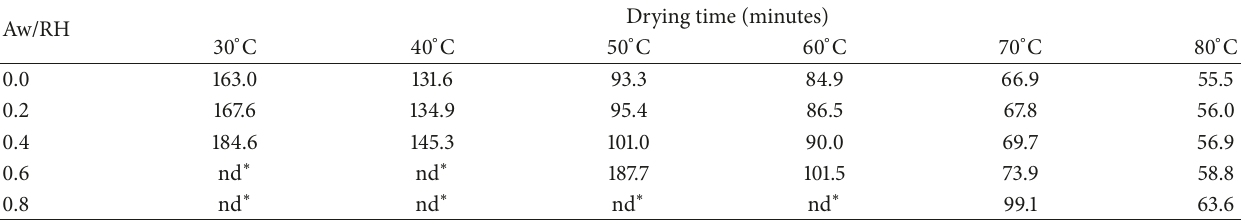
Table 2: Predicted drying time of roselle extract with foam at various air conditions.